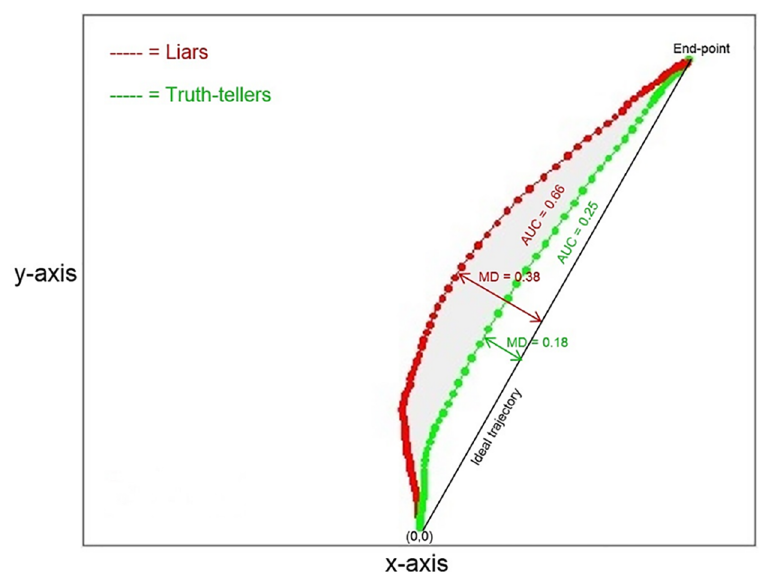
Fig 1. Average trajectoriesfor liars and truth-tellers. The figure represents the averagetrajectories betweenthe subjects, respectivelyfor liars (in red) and for truth-tellers (in green), to the expectedYES and unexpectedYES questions.Expected and unexpectedquestionsthat requirea YES responseare those to which the liars lied. The values of the MD, AUC, x-flip, and y-flip parameters for the two groups are reported. The grey area represents the difference in the AUC parameter betweenthe liars and truth-tellers.